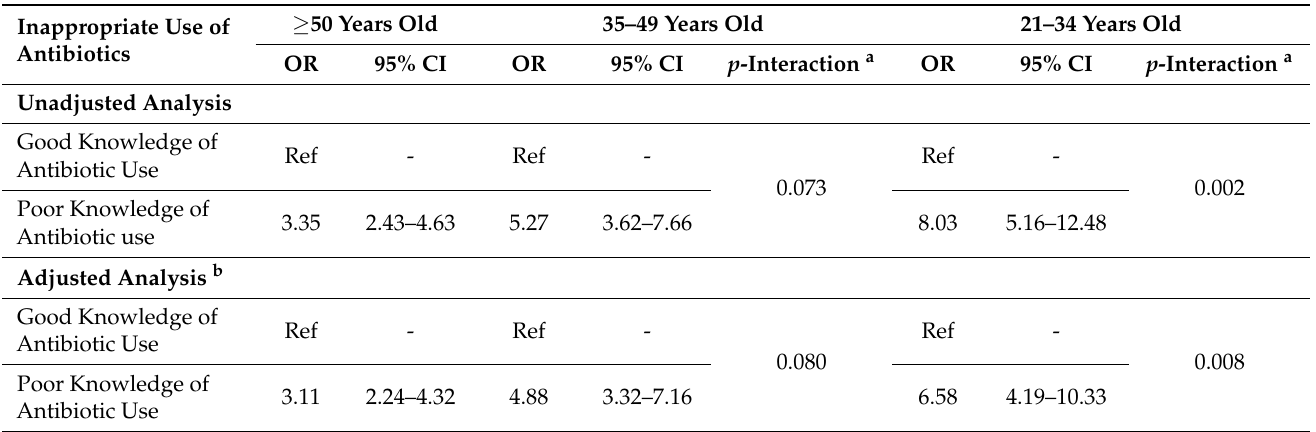
Table 4. Association between inappropriate use of antibiotics and poor knowledge of antibiotic use, according to age